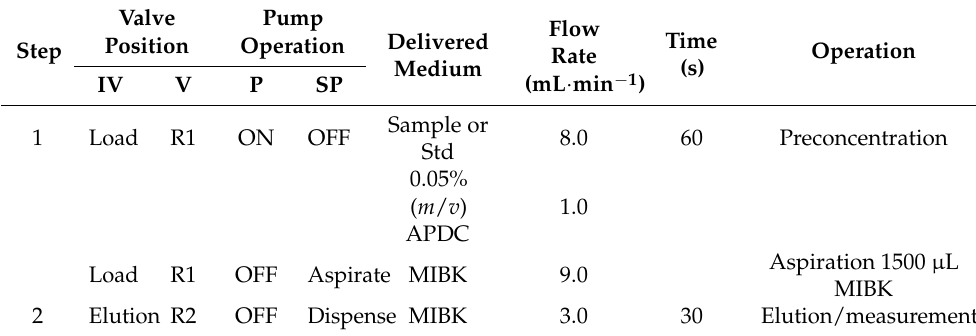
Table 1. Operational sequences of the FI-FCSE-FAAS system for metal